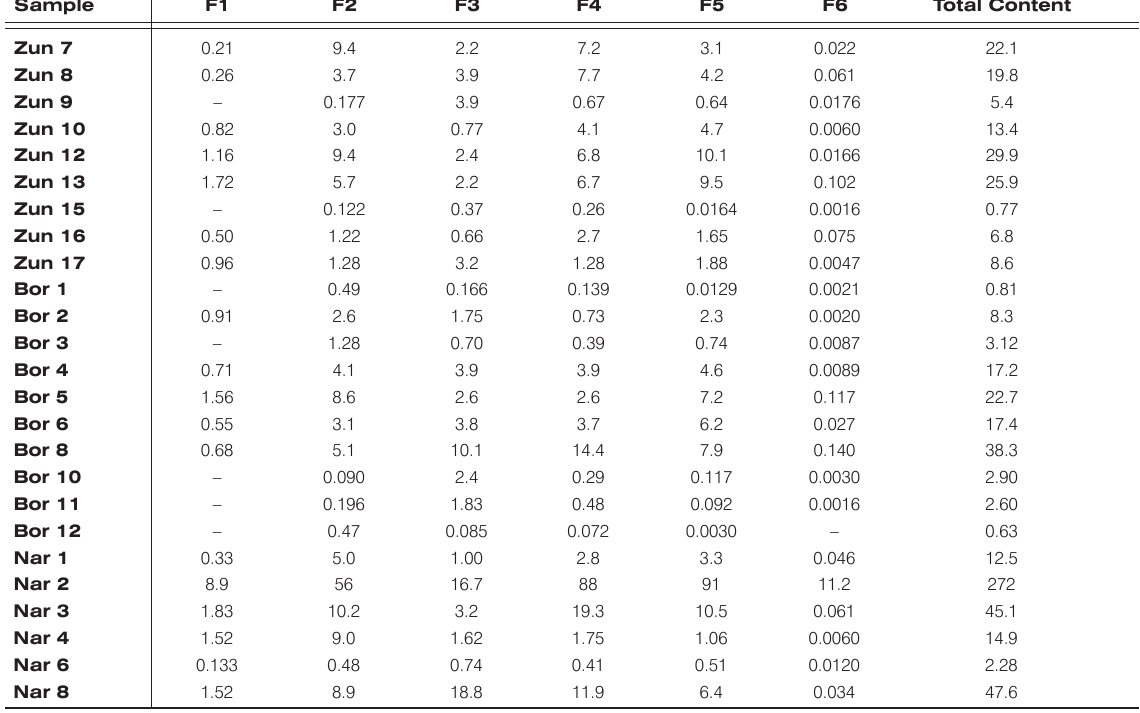
Table 3. Mercury forms content of bulk samples in mg kg -1 .